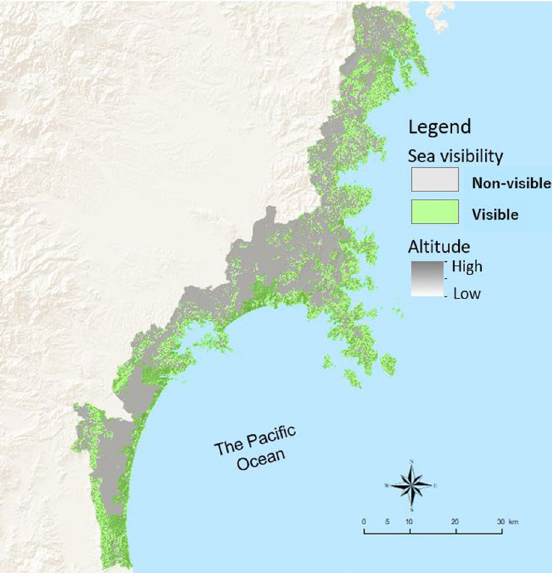
Figure 4. Sea visibility in the study site by viewshed analysis. The map was created by authors using ArcGIS Pro 2.4 (https:// www. esrij. com/ produ cts/ arcgis- deskt op/ envir onmen ts/ arcgis-